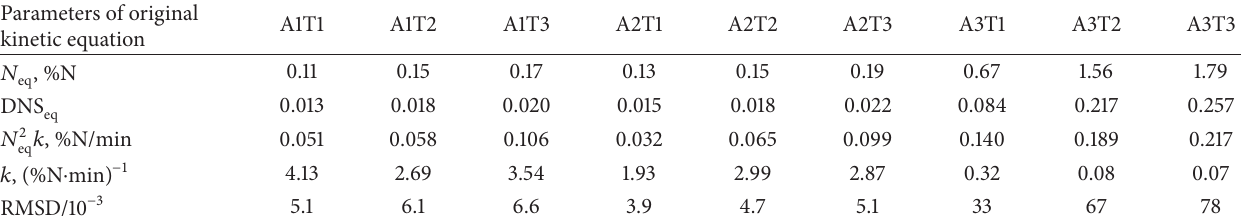
Table 2: Parameters of pseudo-second-order rate equations.